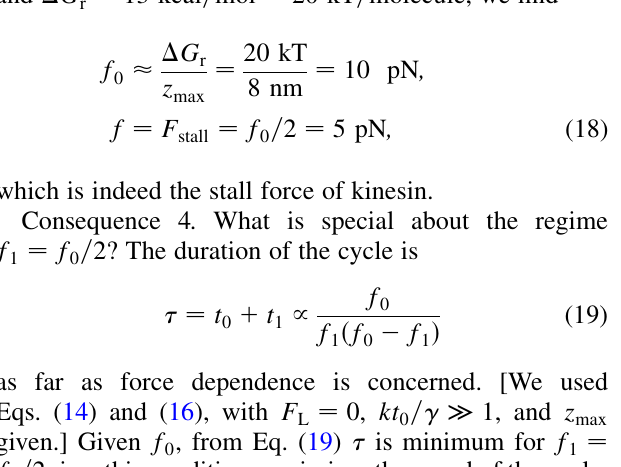
FIG. 5. (a) The ‘‘internal stress’’ j kz model illustrated in Fig. 4. The dashed lines correspond to the jumps in the model. This cycle is qualitatively similar to the schematic cycle proposed in Fig. 3(a), which is itself sug- gested by the measurements of Fig. 2. (b) Simplified representa- tion of the cycle in